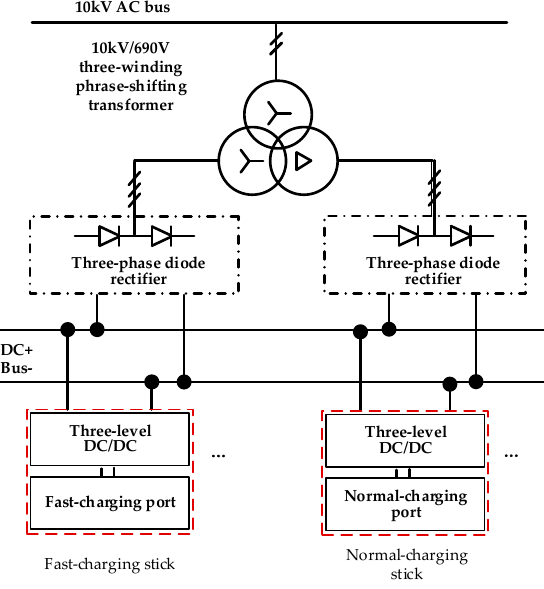
Figure 4. The new charging topology sketch.